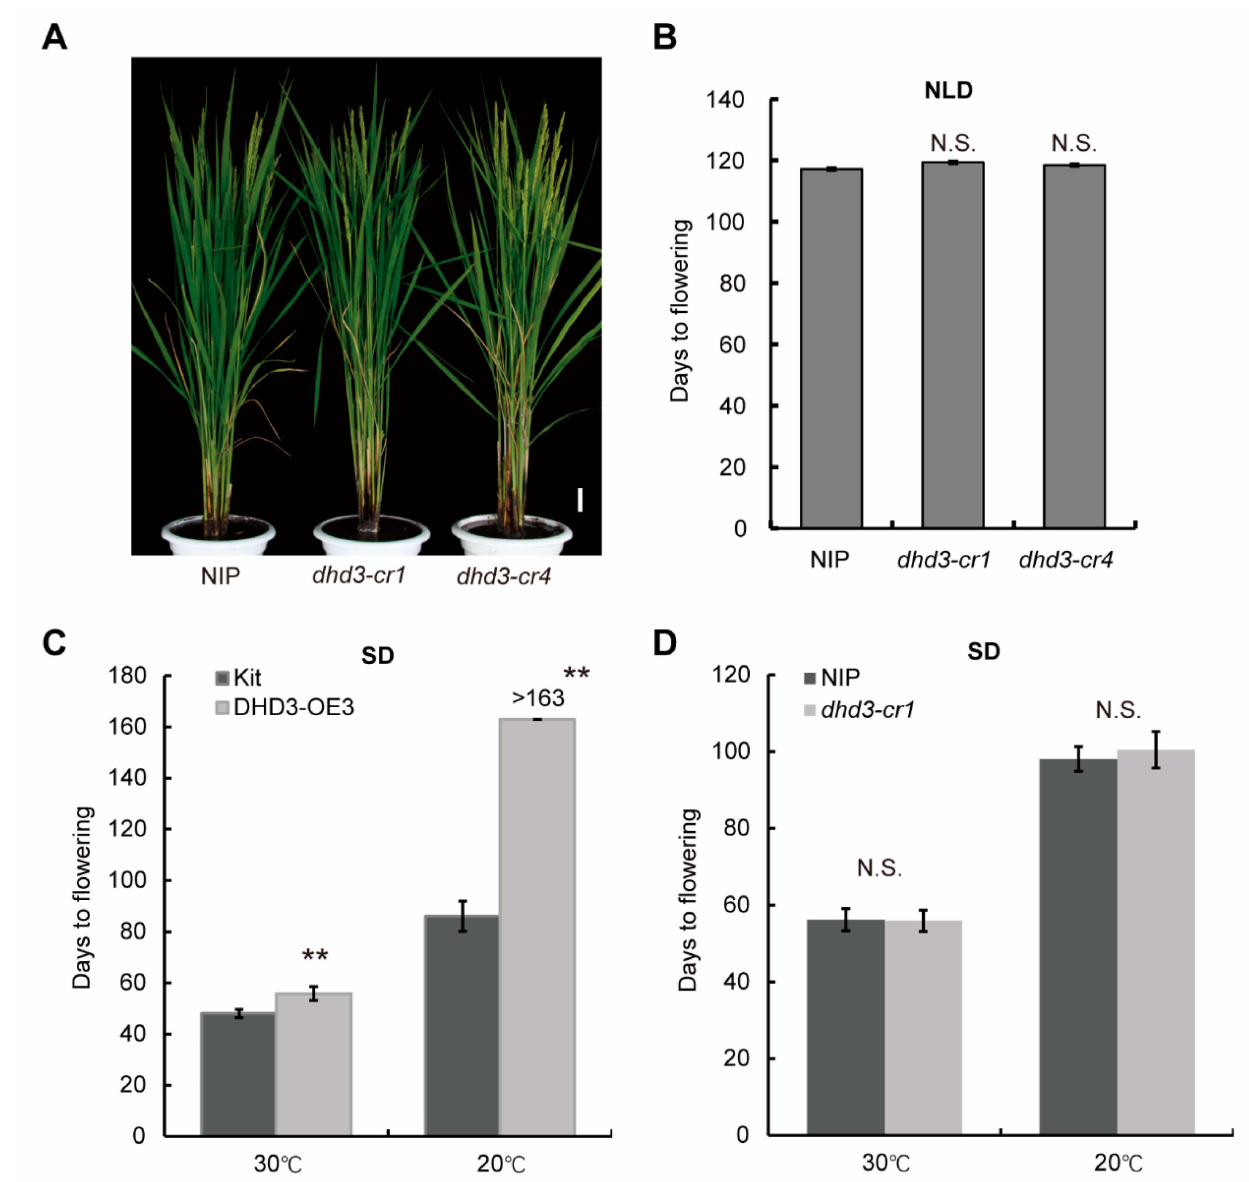
Figure 7. Effect of DHD3–OE plants and dhd3-cr mutant on heading date under low temperature conditions. ( A ) Phenotypes of WT Nipponbare (NIP) and DHD3 CRISPR-KO lines dhd3-cr1 and dhd3-cr4 grown in a paddy field under the NLD condition for 120 days. Scale bars, 5 cm. ( B ) Heading dates of WT NIP, dhd3-cr1 , and dhd3-cr4 grown in a paddy field under the NLD condition. Data are means ± s.e. ( n > 15). N.S., not significant. ( C ) Heading dates of WT Kitaake (Kit) and DHD3– OE3 plants in 30 ◦ C and 20 ◦ C treatments under the SD condition. Data are means ± s.e. ( n > 15). ( D ) Heading date of WT NIP and dhd3-cr1 plants in 30 ◦ C and 20 ◦ C treatments under the SD condition. Data are means ± s.e. ( n > 15). One-way ANOVA test with Tukey correction, ** p ≤ 0.01. N.S., not